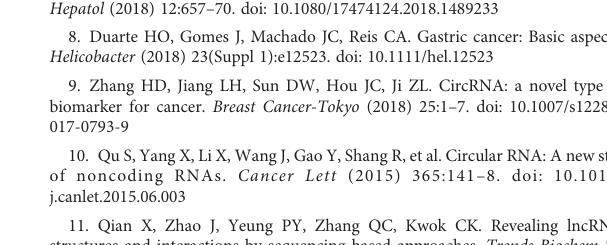
SUPPLEMENTARY FIGURE 13 Correlation between PVT1 and cell cycle